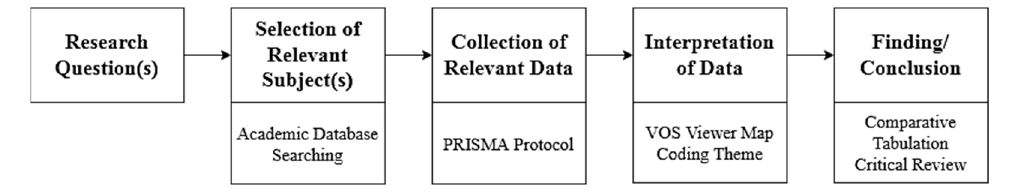
Figure 2. Qualitative research process.